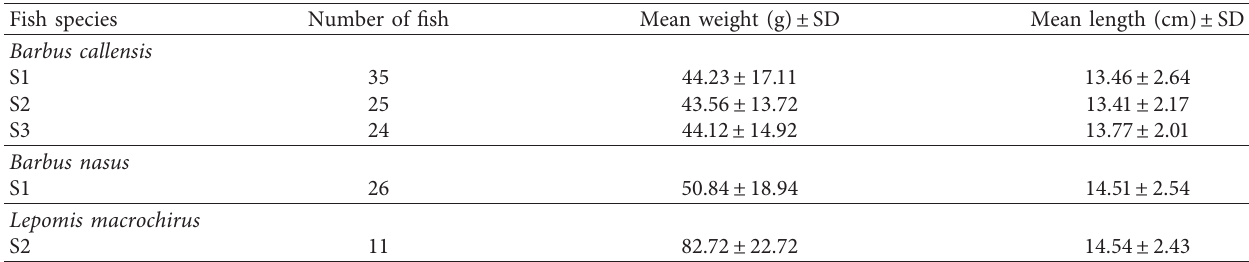
Table 3: Number of fish individuals, weight, and length by sampling sites.